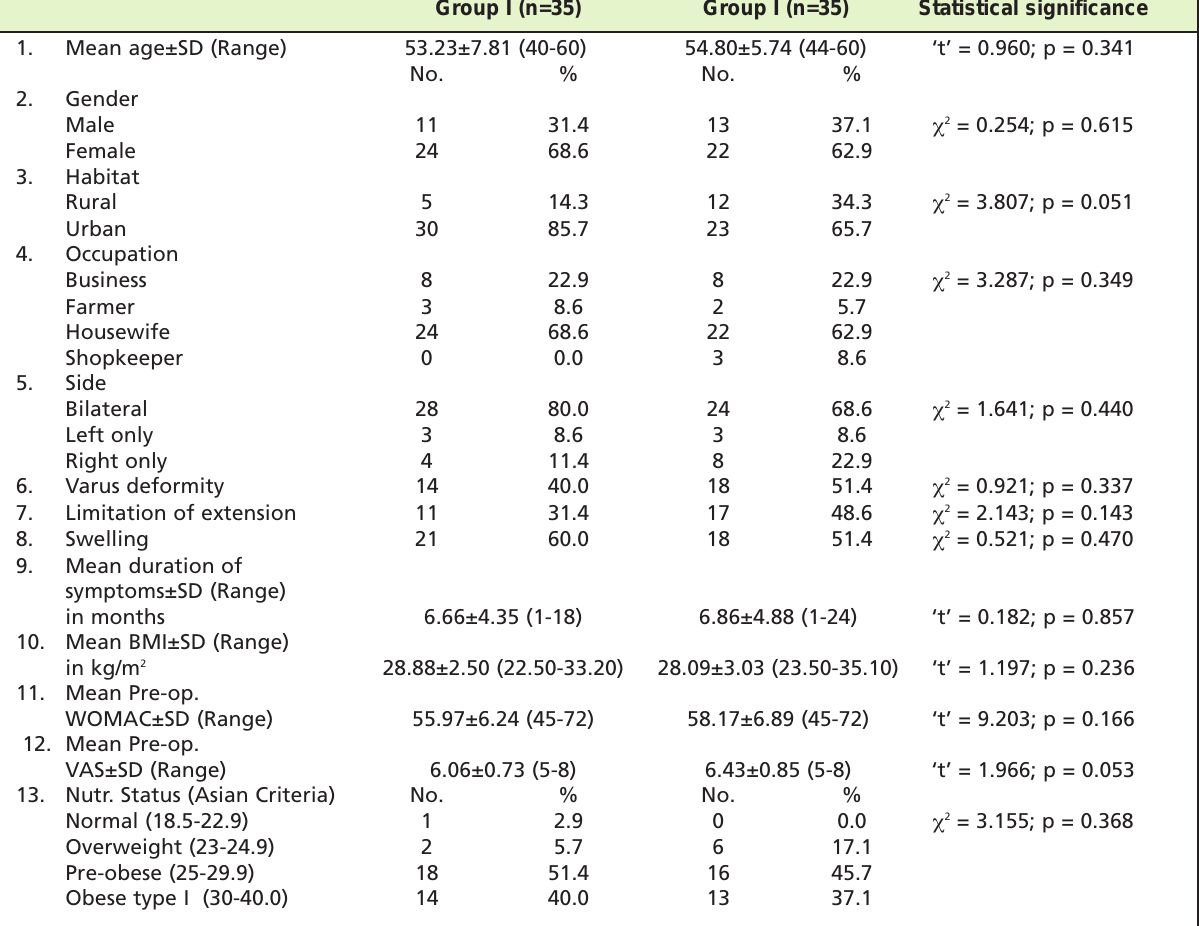
Comparison of General Profile and Disease Characteristics of patients in two groups Table I: